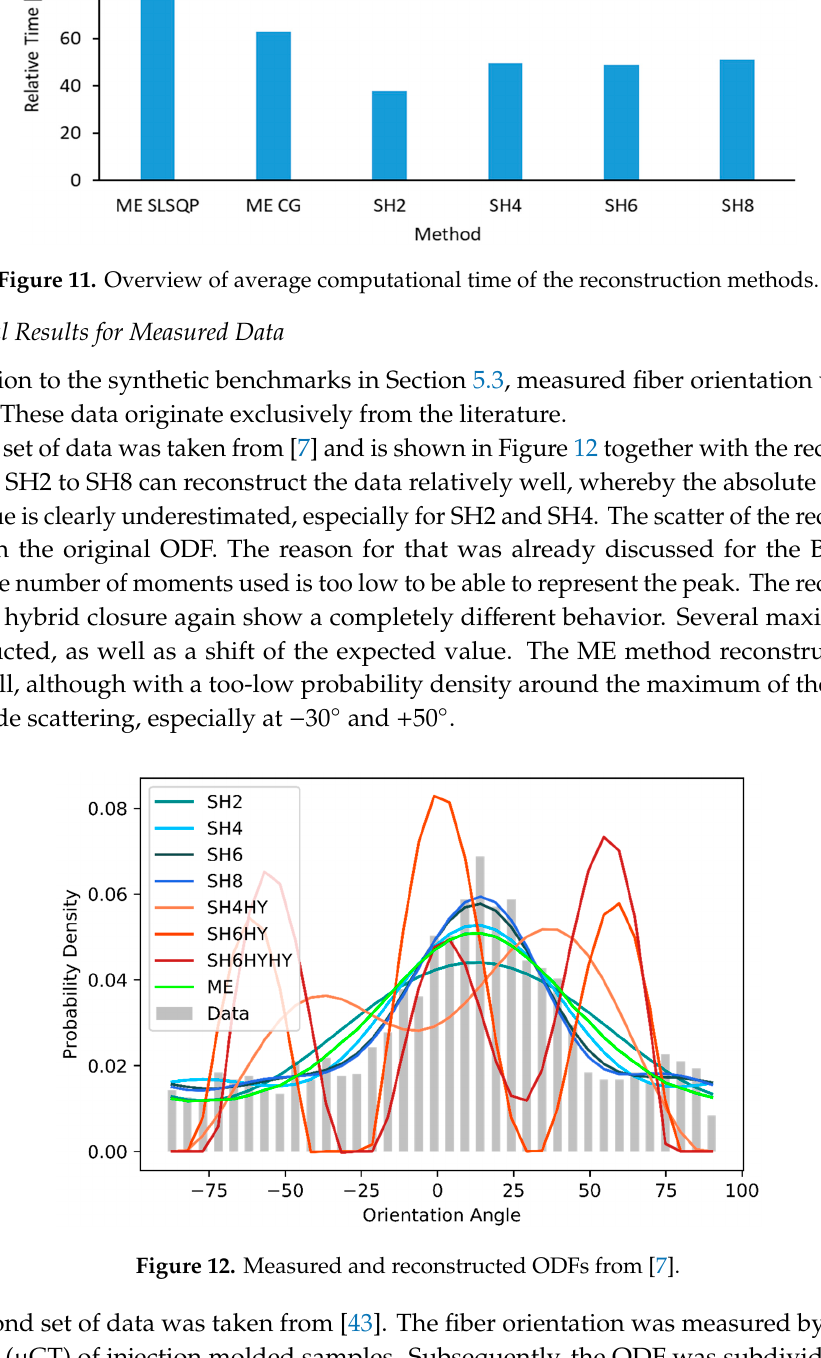
Figure 12. Measured and reconstructed ODFs from [7].